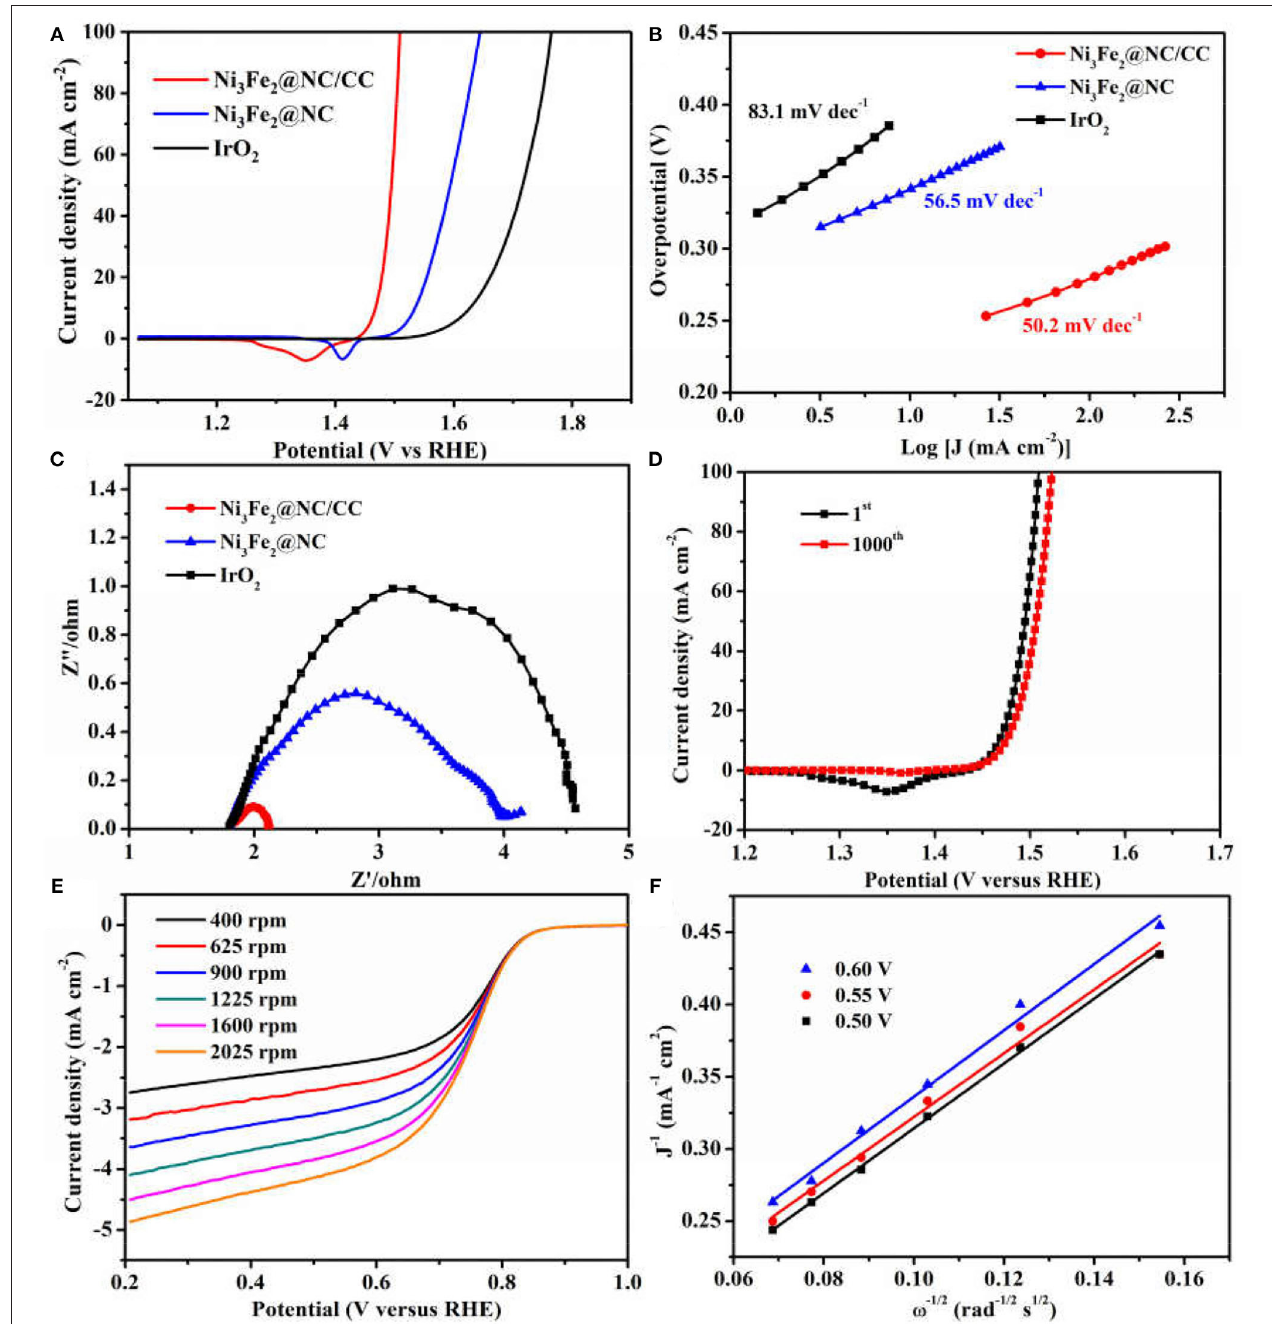
FIGURE 4 | (A) OER polarization curves of Ni 3 Fe 2 @NC/CC, Ni 3 Fe 2 @NC, and IrO 2 . (B) Corresponding Tafel plots. (C) Corresponding EIS spectra. (D) OER LSV plots of Ni 3 Fe 2 @NC/CC before and after 1,000 cycles. (E) ORR polarization curves of Ni 3 Fe 2 @NC at different rotation rates. (F) The K-L plots for Ni 3 Fe 2 @NC at different potentials.